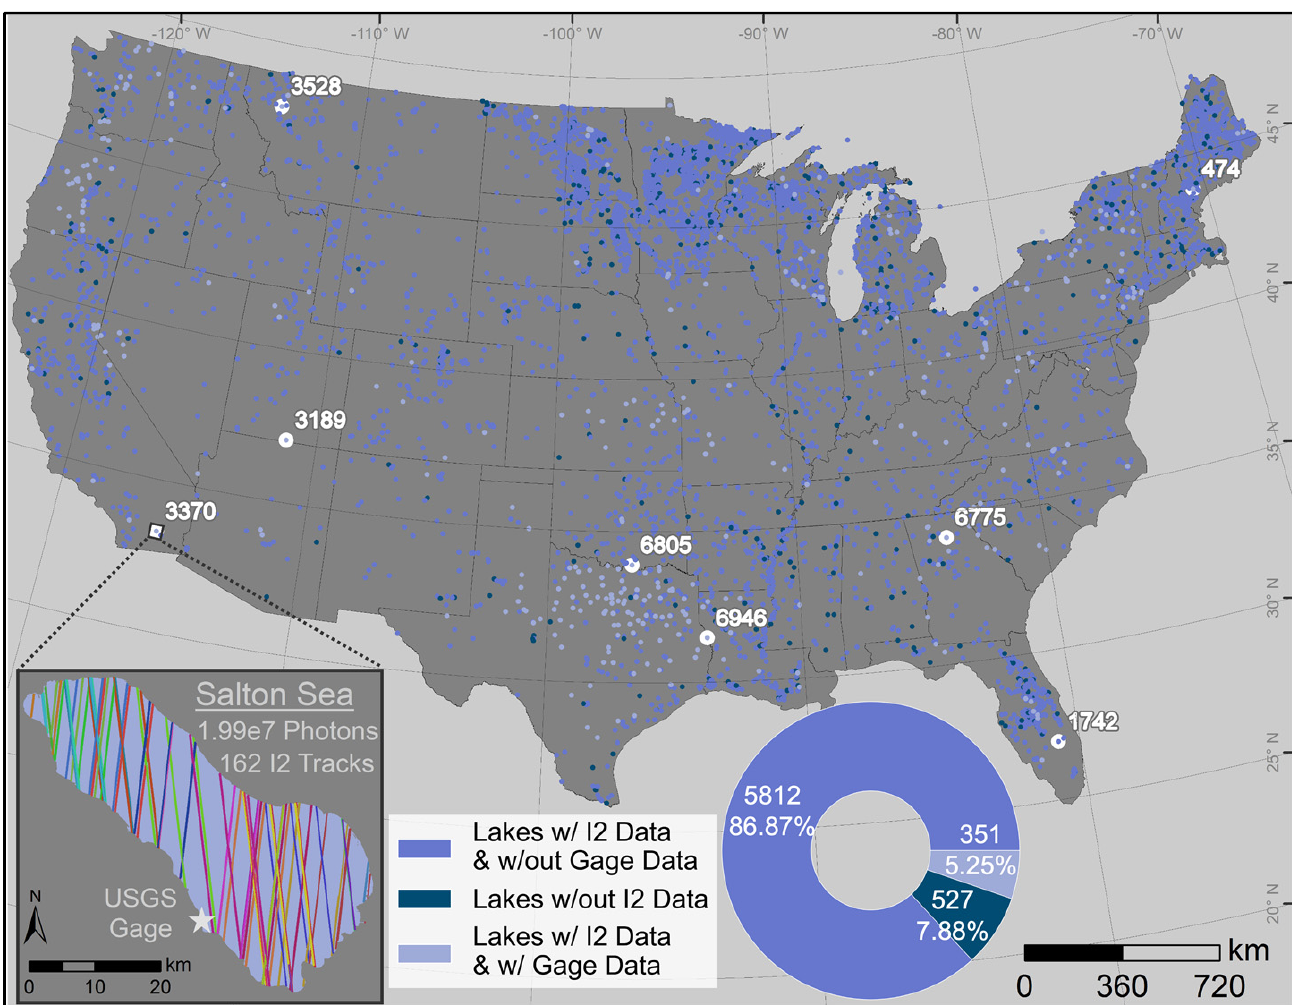
Figure 1. Waterbodies examined in this study classed by data availability. Centroids for all lakes and reservoirs >1 km 2 within the contiguous United States (CONUS) are plotted and are classed by whether or not they have overlapping ICESat-2 data and/or in situ gage data. A donut plot shows the percentage breakdown of these waterbodies by their associated data availability. An inset map is present at the lower-left which displays an example lake within our waterbody mask along with its corresponding gage location and all spatially overlapping ICESat-2 tracks. The location of eight different example waterbodies is labeled by their lake ID and marked by white circles.